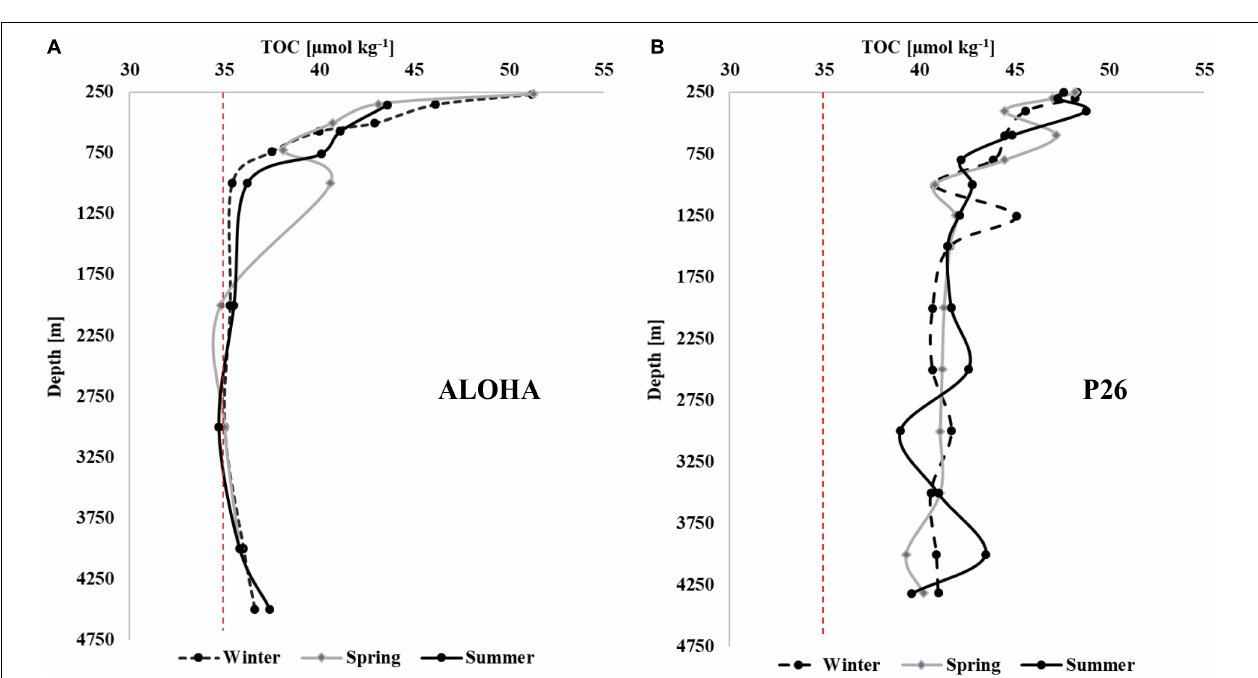
FIGURE 7 | Seasonal TOC [ µ mol kg − 1 ] profiles (winter, spring, and summer) at Station ALOHA (A) and at Station P26 along Line P (B) in 2017. The red dashed line at 35 µ mol kg − 1 provides a visual reference point emphasizing the differences in concentrations between subtropical and subpolar systems. HOT data are accessible at http://hahana.soest.hawaii.edu/hot/hot-dogs/bextraction.html. Concentrations at Station ALOHA are referred to here as TOC, rather than DOC as listed at the HOT data archive, since the samples were collected and analyzed as whole-water.